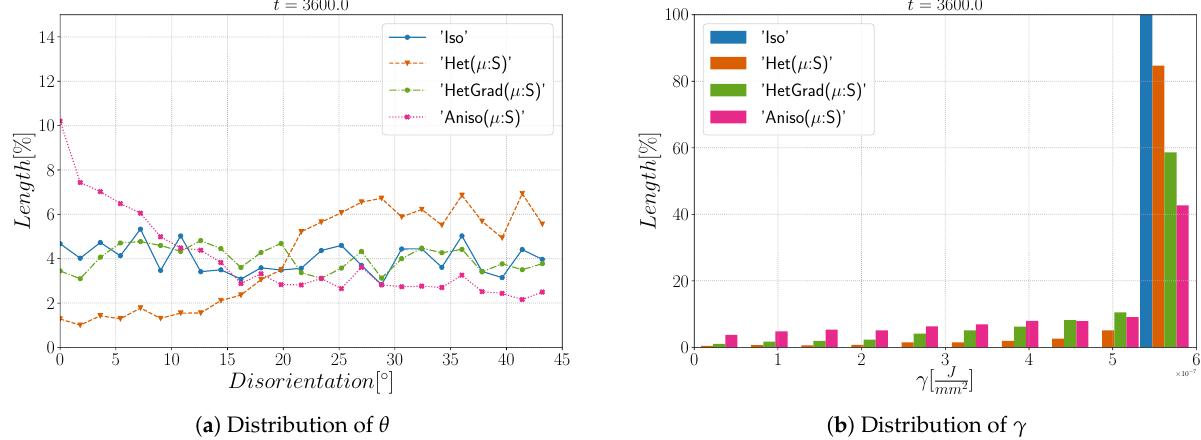
Figure A15. Grain boundary characteristics’ distributions at t = 1